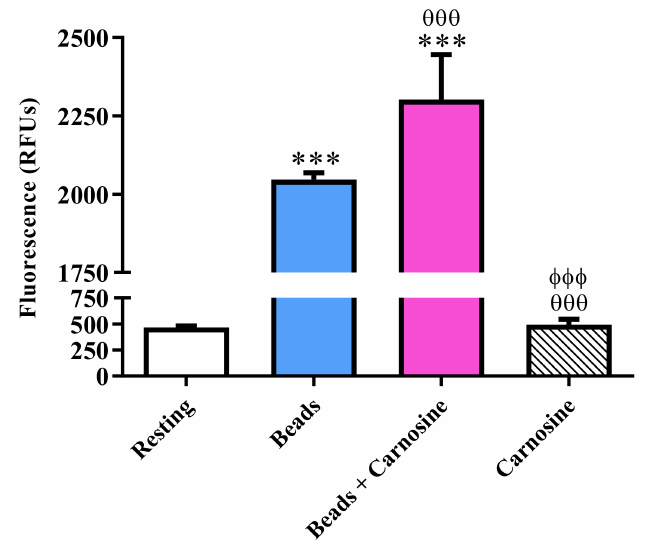
Figure 8. Measurement of macrophage phagocytic activity in resting RAW 264.7 cells and in RAW 264.7 cells stimulated with antibody-bound tentagel beads in the absence or presence of carnosine (20 mM; 1 h pre-treatment). Data are the mean of 3 to 8 independent experiments and are expressed as relative fluorescence units (RFUs). Standard deviations are represented by vertical bars. *** significantly different from resting cells, p < 0.001; ѲѲѲ significantly different from bead-treated cells, p < 0.001; ϕϕϕ significantly different from beads + carnosine-treated cells, p <